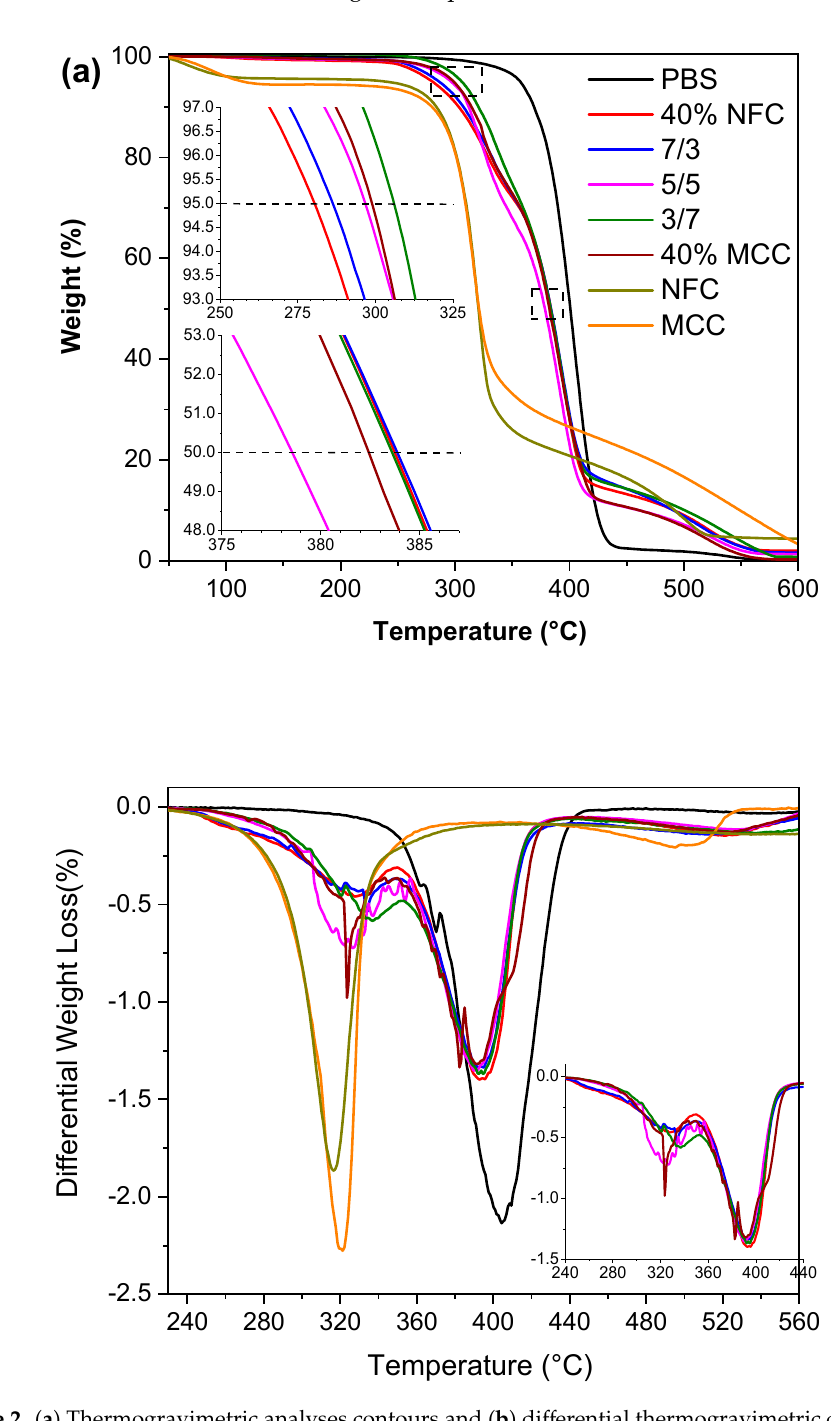
Figure 2. ( a ) Thermogravimetric analyses contours and ( b ) differential thermogravimetric contours of PBS, PBS/cellulose composites, NFC and MCC under air atmosphere. Table 3. Thermal properties of PBS/cellulose composites.